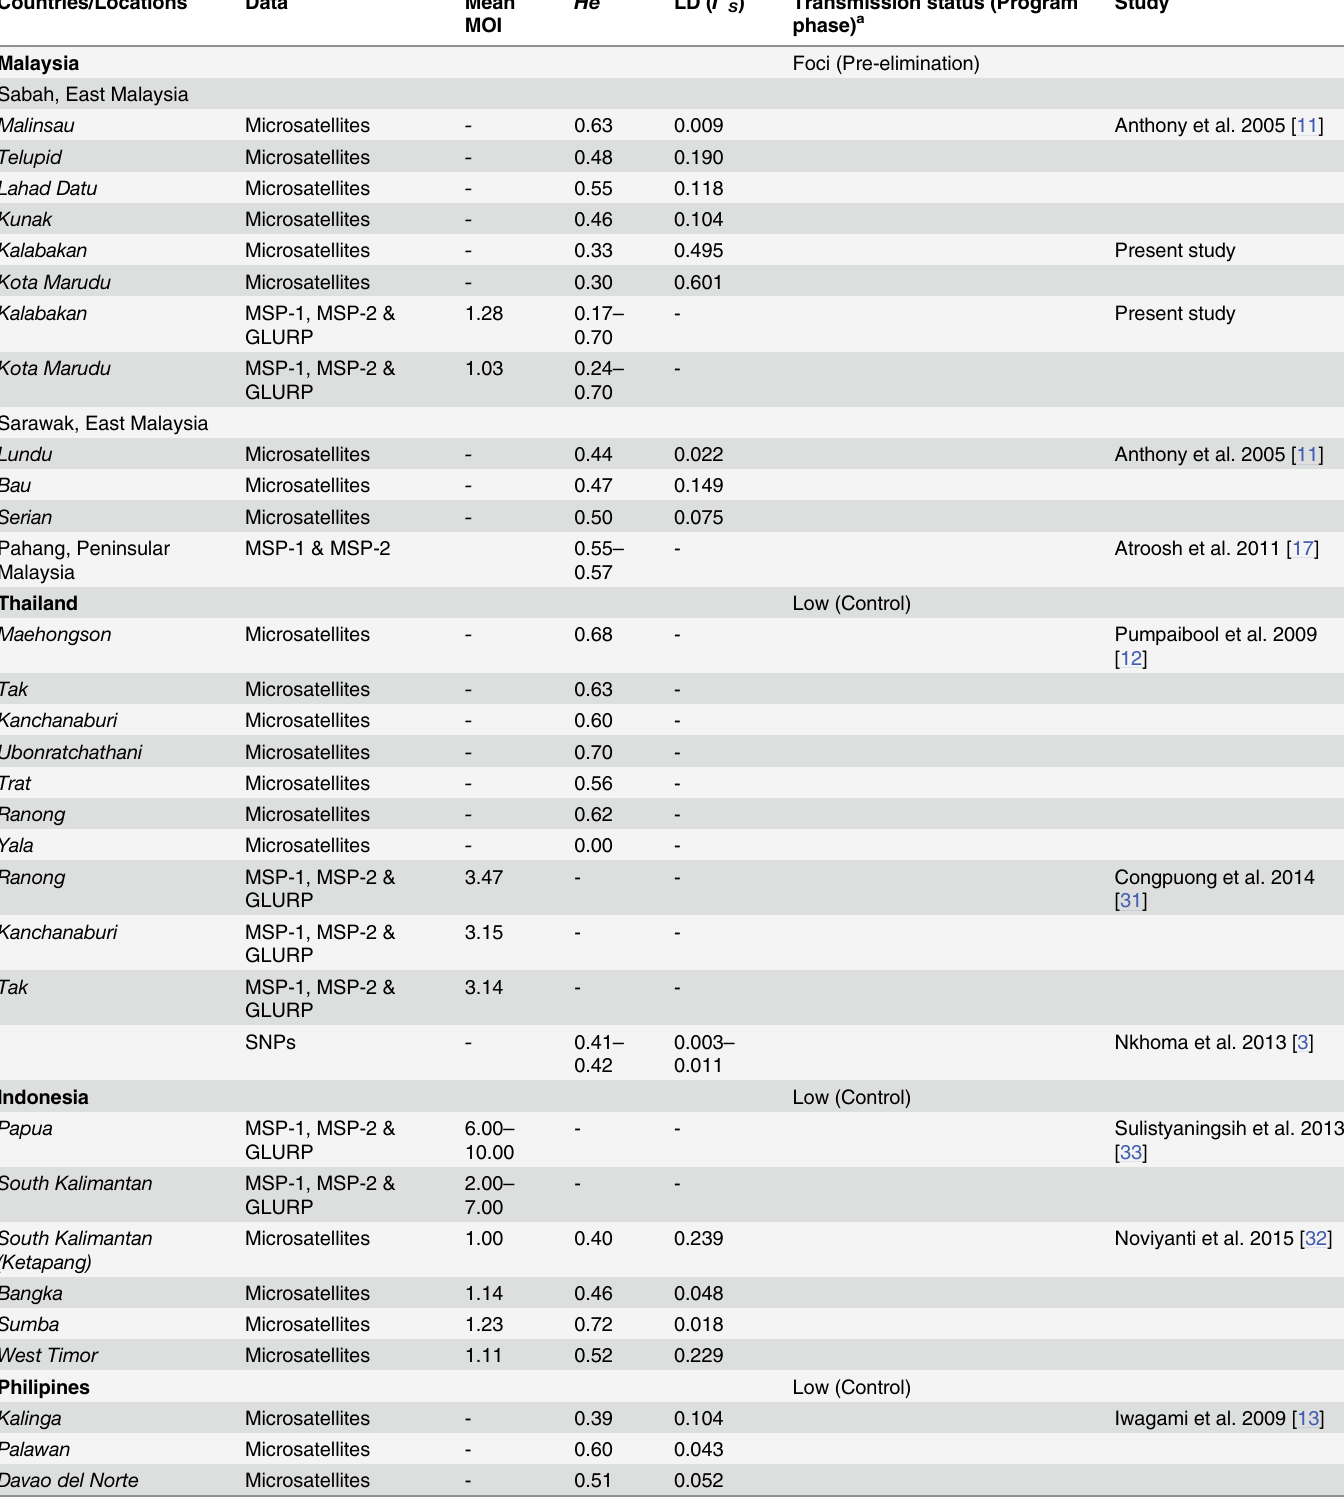
Table 9. The diversity level of P . falciparum populations in different transmission settings.